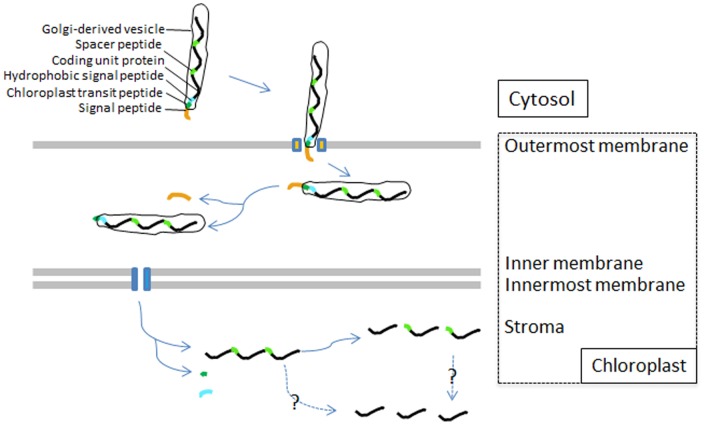
Schematic of PdRBC import pathway into the chloroplast in P. donghaiense.The precursor polypeptide consists of a signal peptide (orange) followed by a chloroplast transit peptide (deep green) and a hydrophobic signal peptide (blue). The signal peptide leads the polyprotein through the outermost membrane. The chloroplast transit peptide guides the polyprotein into the two inner membrane and then is cleaved off, unmasking the hydrophobic region peptide to stop transfer. The dashed arrows depict unknown cleave mechanism.